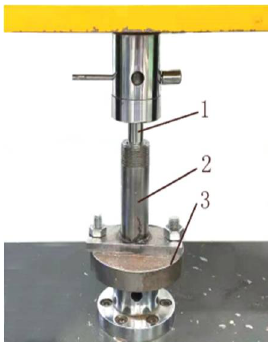
Figure 3. The diagram of compaction apparatus: 1—plunger; 2—die sleeve; 3—pedestal. 3. Microcomputer-controlled electronic universal testing machine (Model: 4050, Reger, Shenzhen, China), electronic balance(Model: SF-400A, Shanghai, China) (accuracy: 0.01 g), moisture tester (model: SC69-02, Shanghai, China), vernier caliper(precision: 0.01 mm), etc.